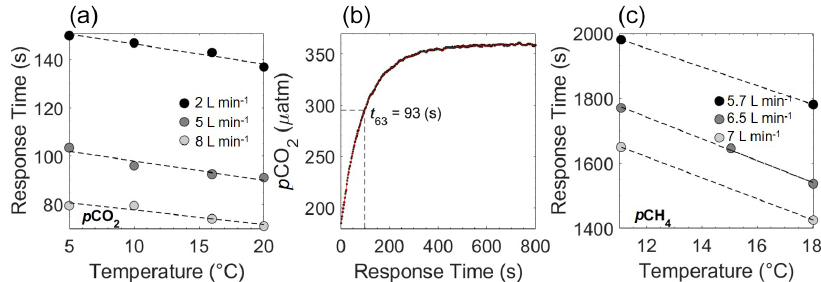
Figure 5. Response time (s) of the HC–CO 2 determined at four temperatures within controlled laboratory conditions for different water flow rates (2, 5 and 8Lmin − 1 ) with errors too small to see (a) . An example of the output (b) shows how t 63 is retrieved after a zeroing interval, with t 63 determined by the model’s fit (line in red). Response time (RT) for p CH 4 is also shown (c) for flow rates of 5.7, 6.5 and 7Lmin − 1 conducted in controlled conditions at KMCON. Table 2. Cruise table for all field campaigns in 2016 and 2017, with cruise/ship names (cruise ID in italic), areas and observed maximum to minimum values for all measured parameters (in italic). For p CO 2 , the sensor is only factory calibrated up to 6000ppm; therefore, this was deemed as being the maximum in these